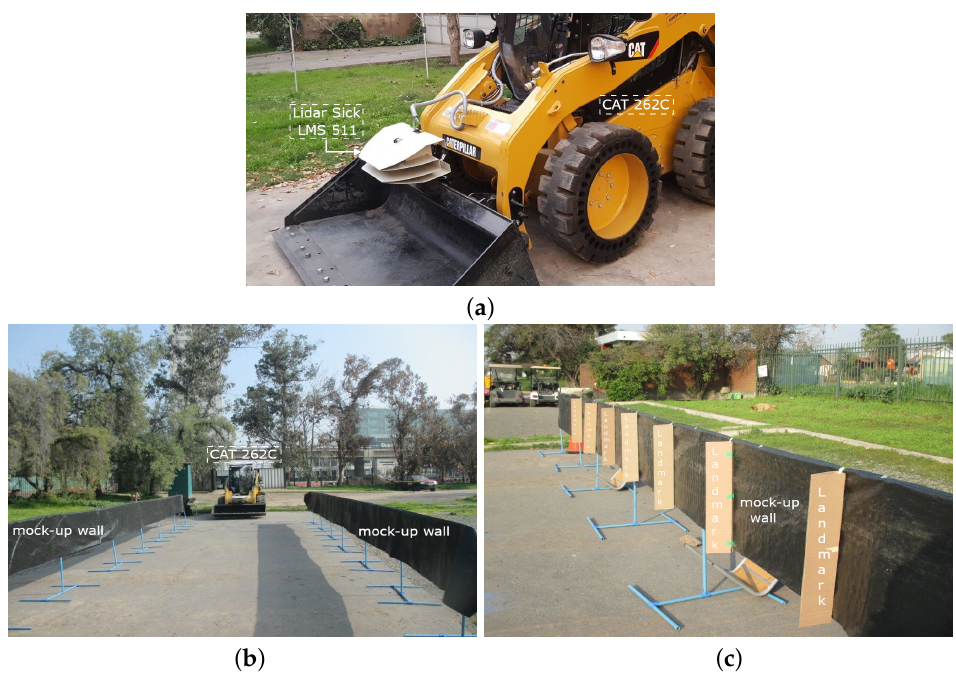
Figure 1. Experimental setup showing the semi-autonomous CAT 262C and the mock-up tunnel: ( a ) CAT 262C and the front lidar Sick LMS 511; ( b ) Tunnel mock-up without landmarks; ( c ) Tunnel mock-up with